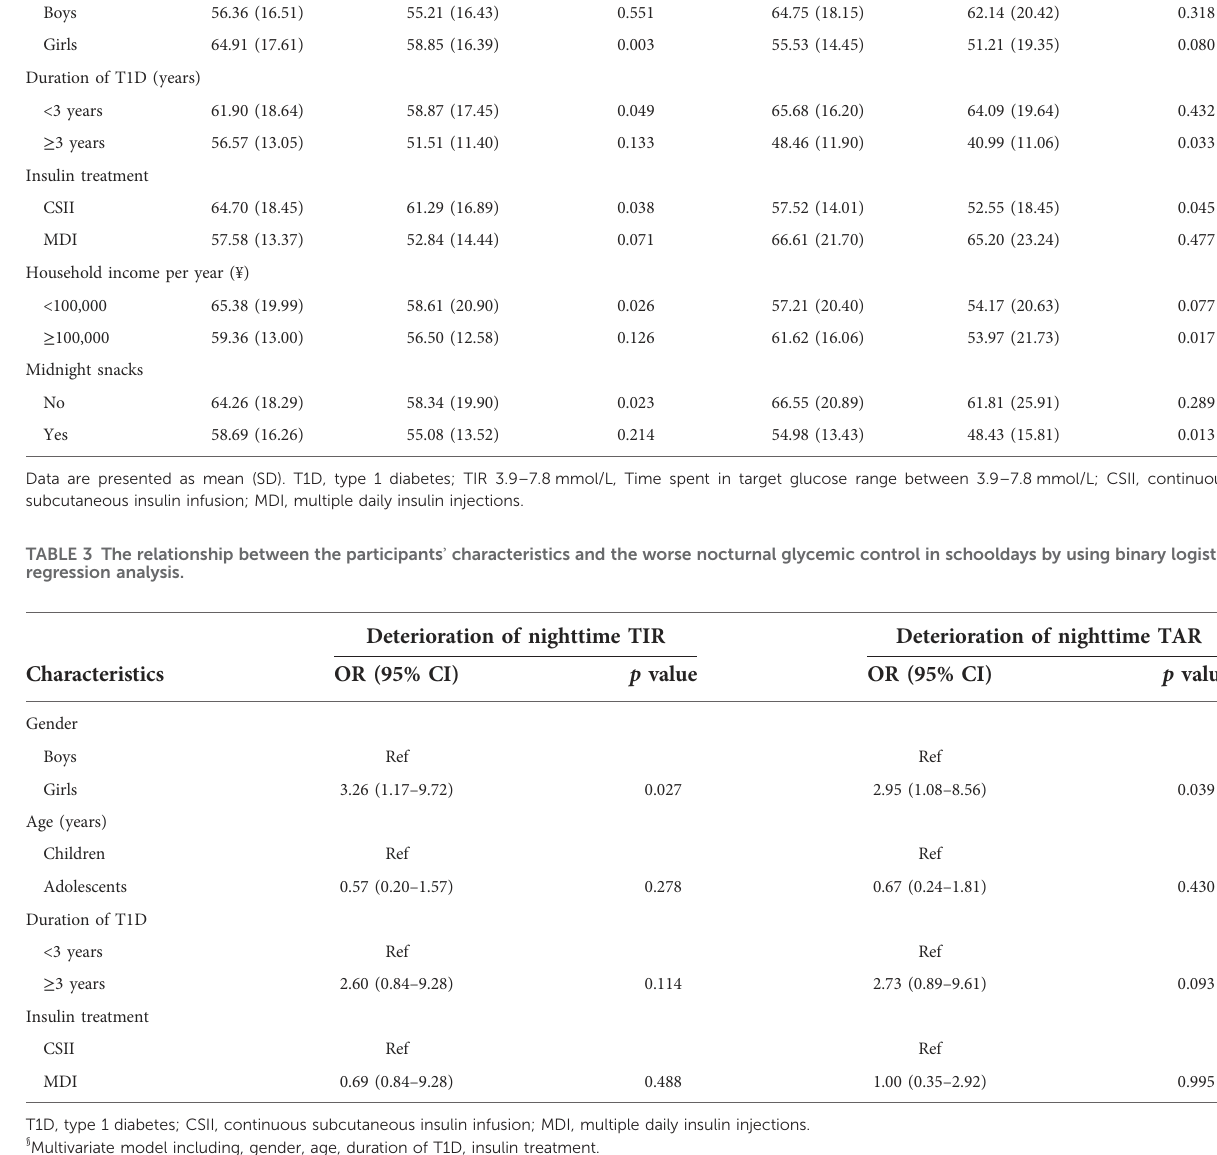
Table S3 . Similar trends were found in these fi ndings. To evaluate the associations between the aforementioned factors and the poorer nocturnal glycemic control identi fi ed during schooldays, logistic regression analysis was performed.